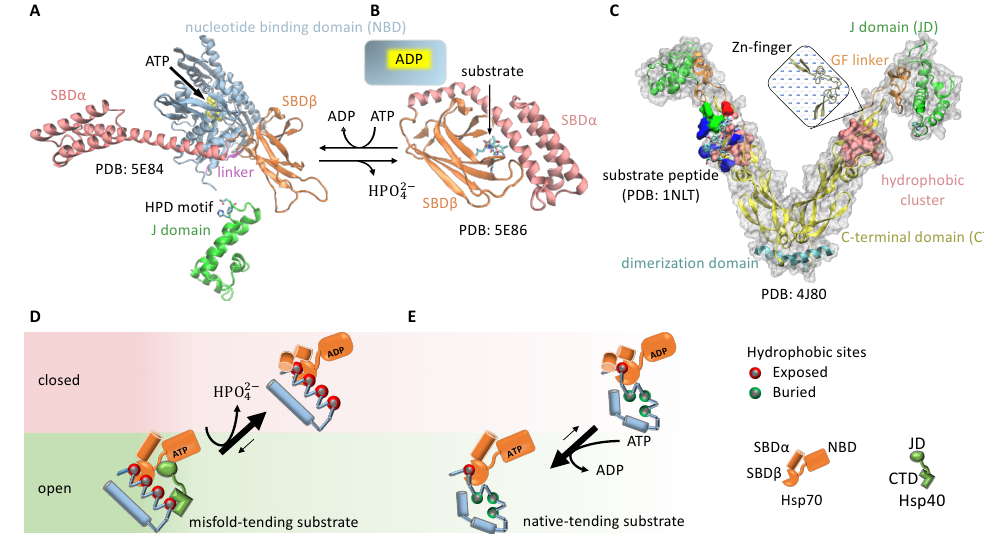
Figure 3. Cochaperone Hsp40 enables Hsp70 to change the balance between its open and closed states in response to the conformation of a bound substrate. ( A ) the ATP-bound, open state of Hsp70, which allows rapid binding and unbinding of the substrate; ( B ) the ADP-bound, closed state of Hsp70, with slow binding and unbinding of the substrate. SBD: substrate binding domain. ( C ) the structure of the Hsp40 cochaperone, including CTD that can bind to exposed hydrophobic sites on a substrate and the J domain that can stimulate the ATP hydrolysis of Hsp70. ( D ) An Hsp70 bound to a misfold-tending substrate molecule with many exposed hydrophobic sites is likely to be in proximity to an Hsp40 bound to the same substrate molecule, thus the Hsp70 will be stimulated in ATP hydrolysis, which drives the Hsp70 to its ADP-bound, closed state. ( E ) An Hsp70 bound to a native-tending substrate molecule with few exposed hydrophobic sites is unlikely to have a nearby Hsp40 and thus unlikely to be stimulated in ATP hydrolysis, and nucleotide exchange drives the Hsp70 toward its ATP-bound, open